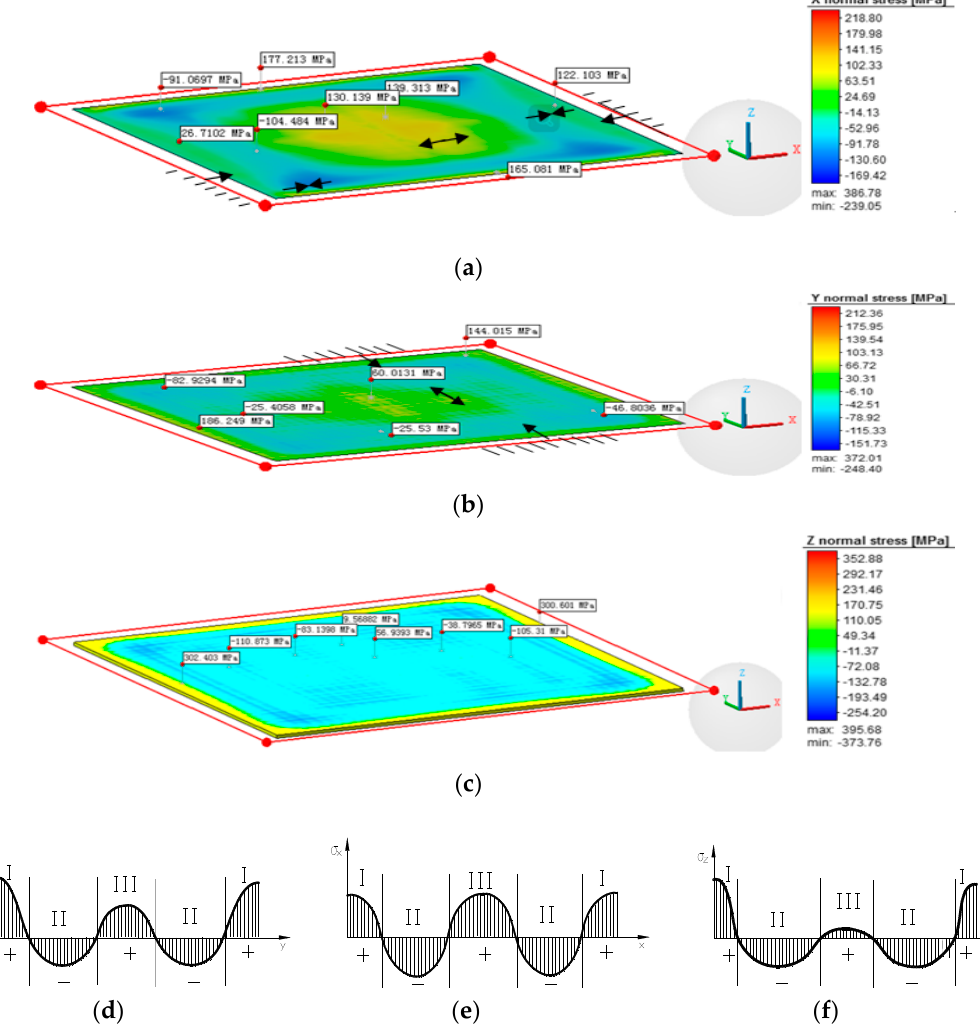
Figure 7. Distribution trend of uniaxial thermal stress: ( a ) X-direction nephogram; ( b ) Y-direction nephogram; ( c ) Z-direction nephogram; ( d ) σ x scattergram; ( e ) σ y scattergram; ( f ) σ z scattergram.